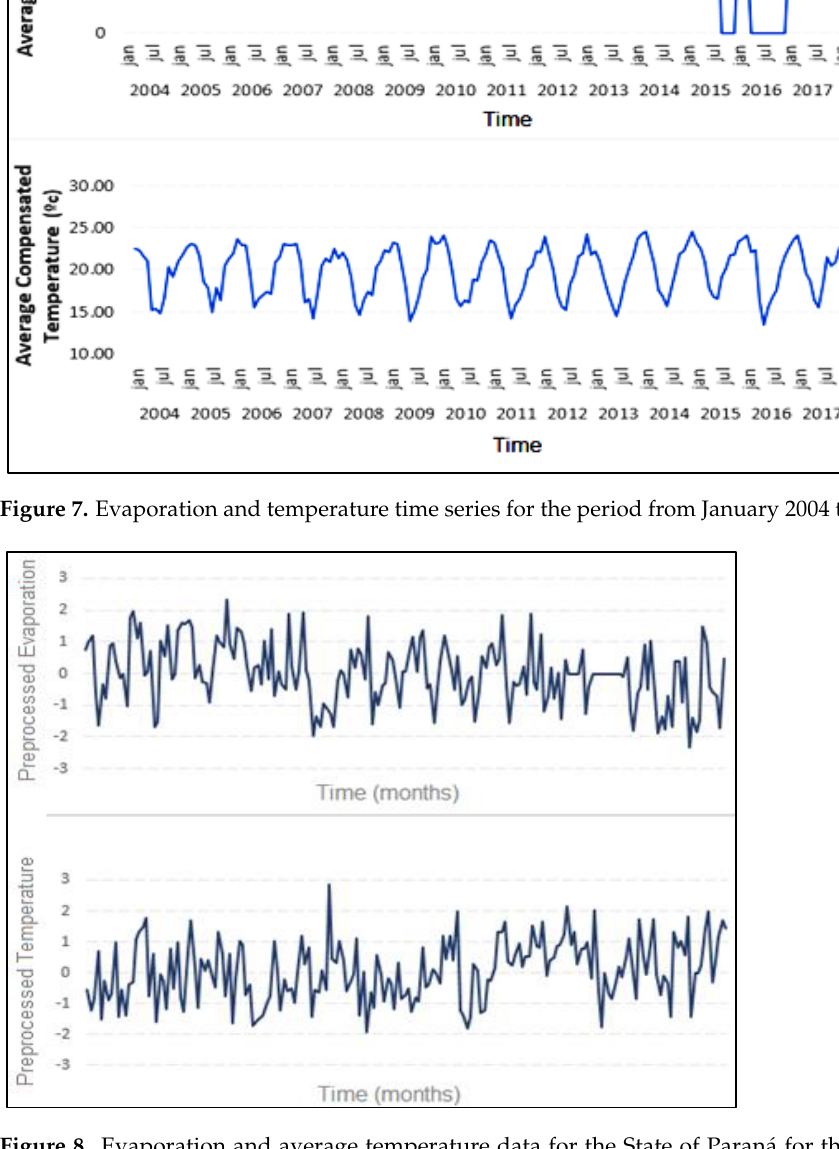
Figure 7. Evaporation and temperature time series for the period from January 2004 to June 2019.